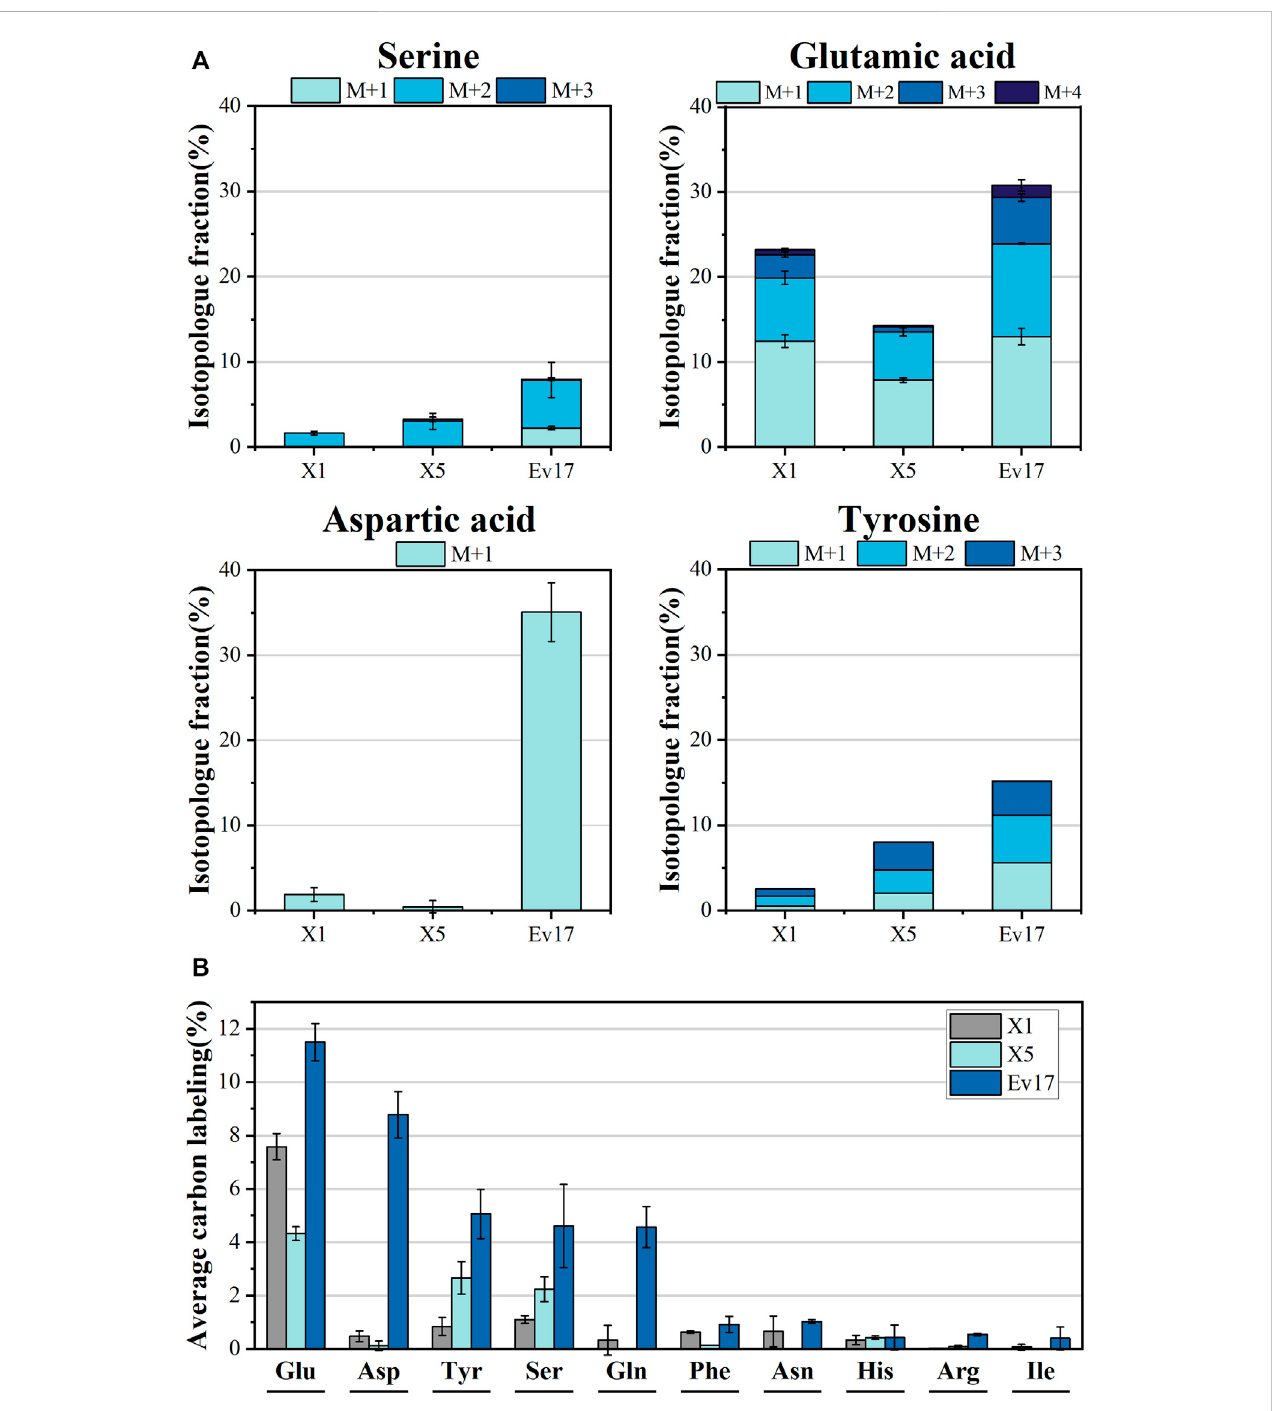
by XuMP cycle running more than one time. All of the measured metabolites in strain Ev17 showed higher average 13 C-labeling and had more than one 13 C atom, con fi rming the signi fi cant improvement of methanol assimilation via